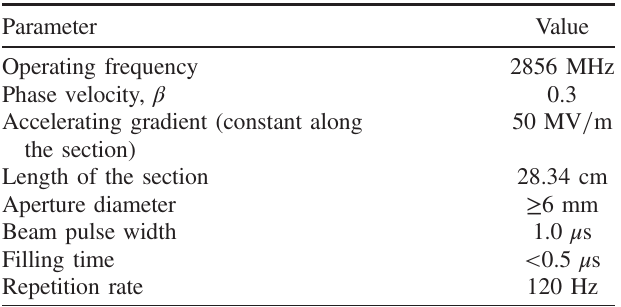
TABLE II. The requirements for the ACCIL β ¼ 0 . 3 section. Parameter Value Operating frequency